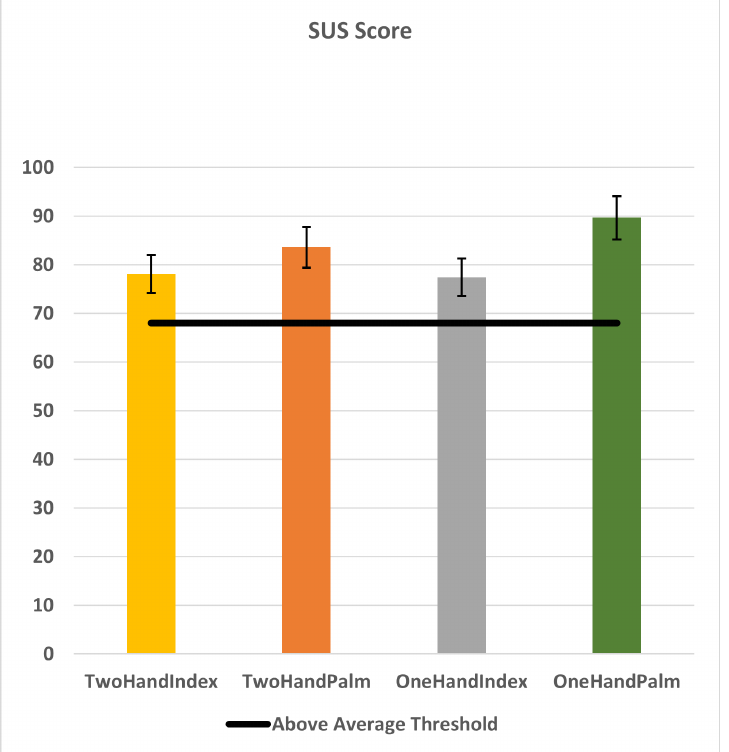
Figure 12. Average System Usability Scale (SUS) scores for each method, indicating the subjects’ perceived usability. The line shows threshold of 68, which indicates an above average